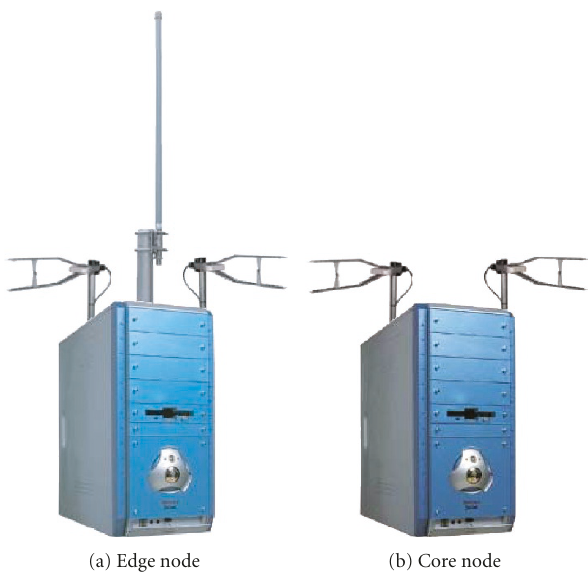
Figure 2: WVSN topology.